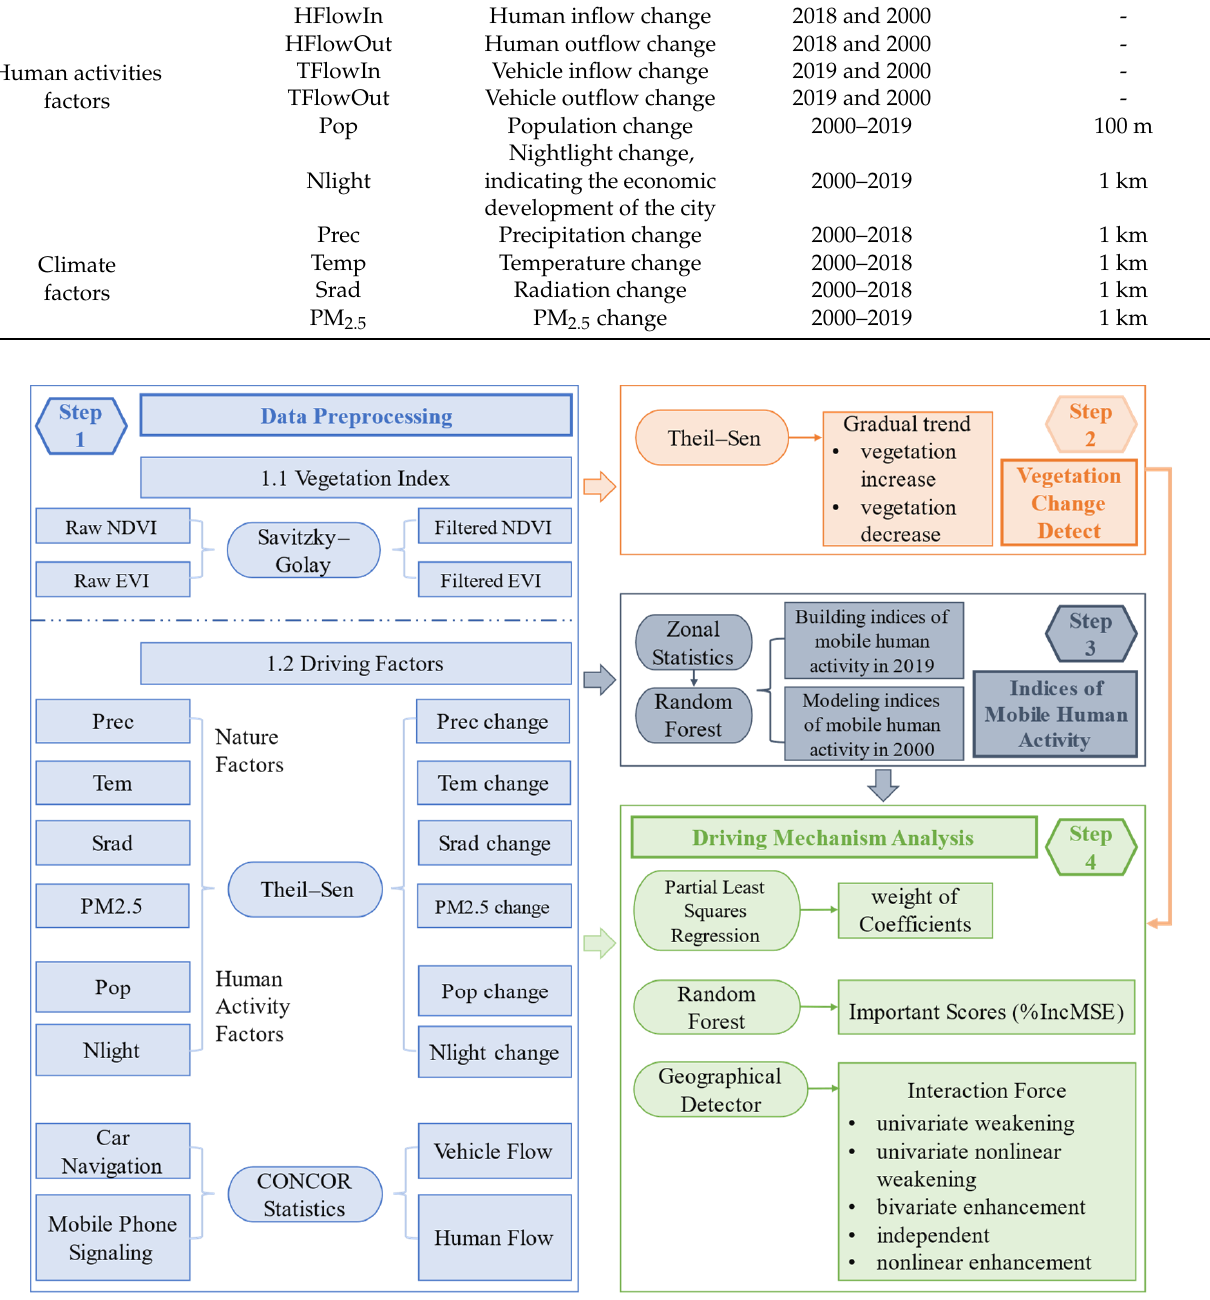
Figure 2. The f ramework between vegetation change and its driving factors. Figure 2. The framework between vegetation change and its driving